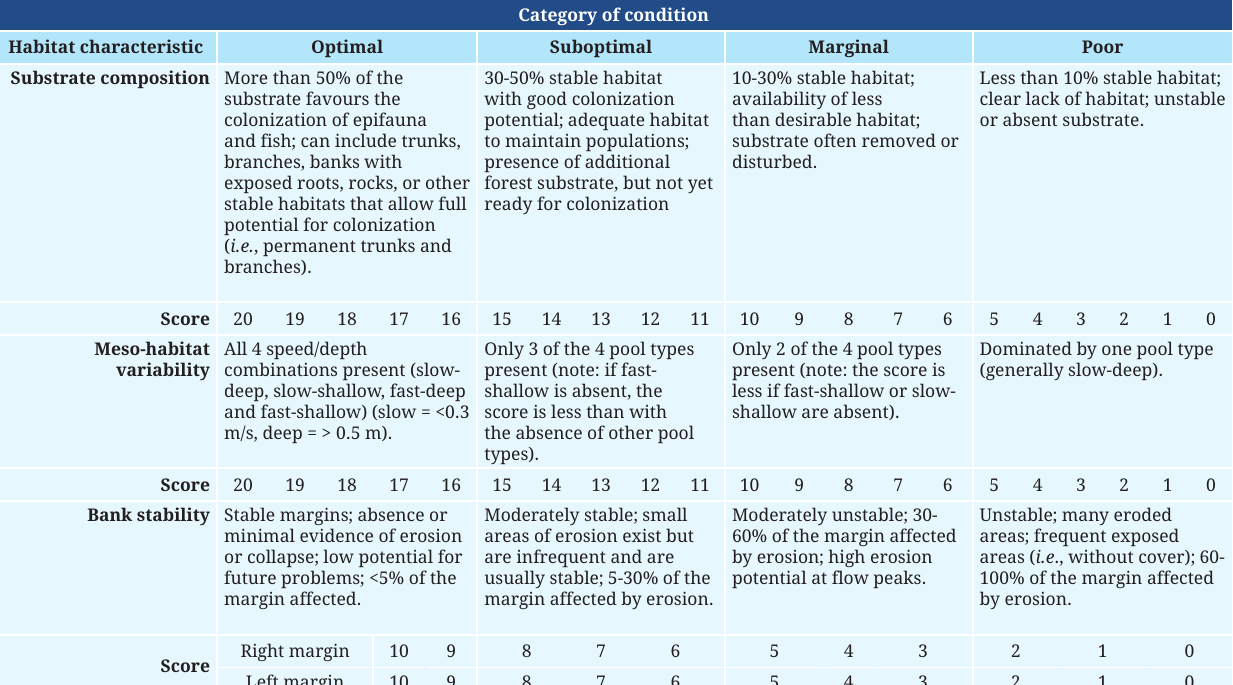
TABLE 1 | Criteria selected to determine the habitat score based on the substrate composition, meso-habitat variability, and bank stability habitat characteristics (Adapted from Barbour et al .,